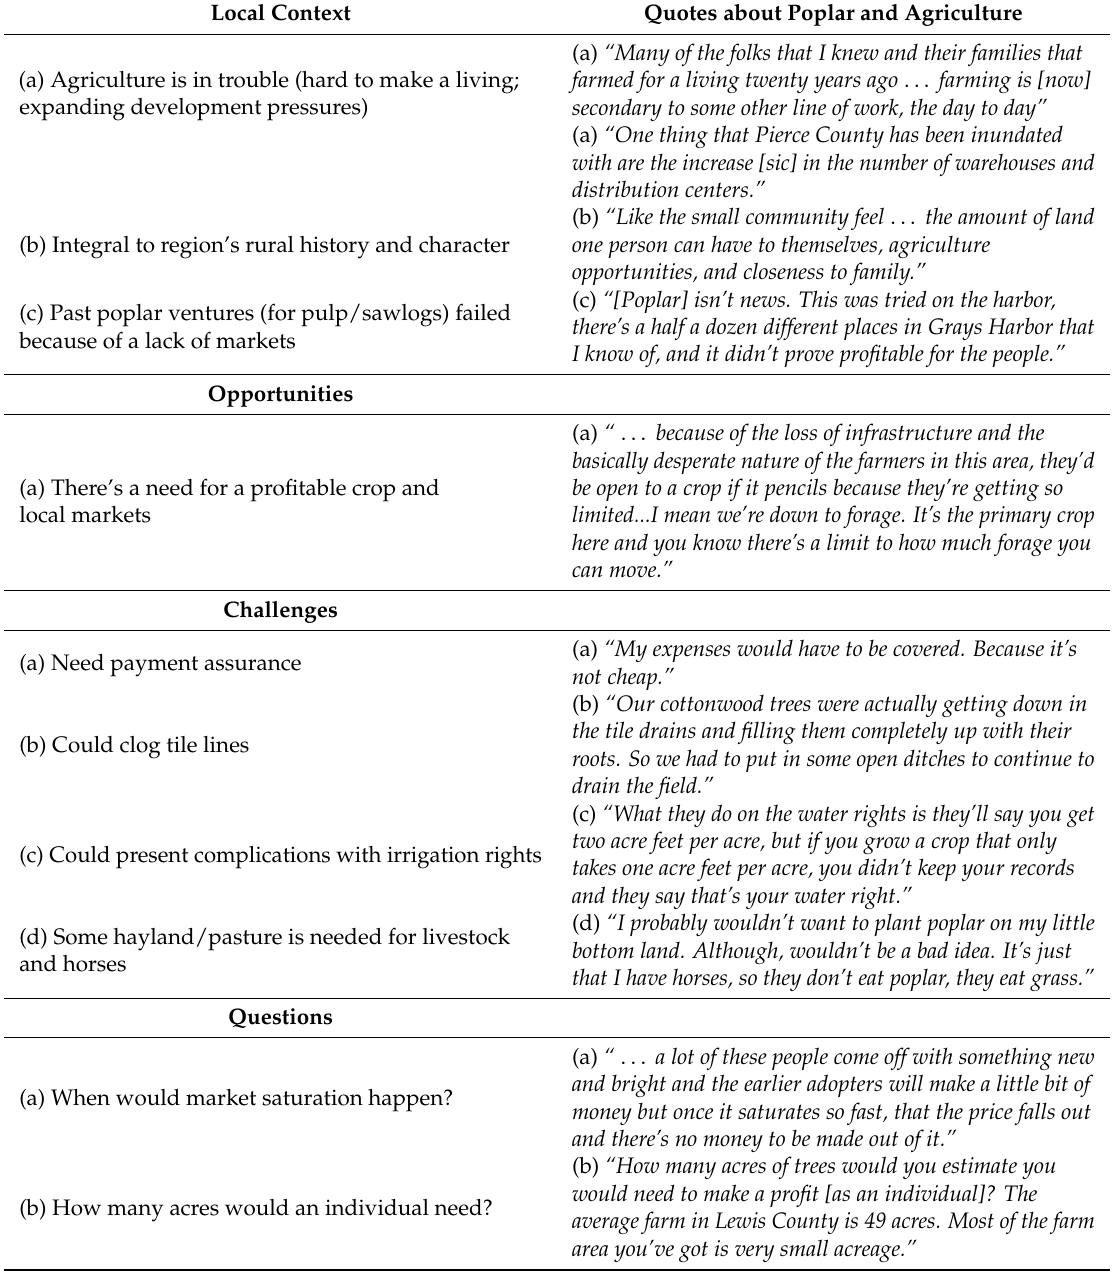
Table 3. Summary and quotes related to the potential for poplar farming to contribute to agriculture in southwestern Washington, from participant stakeholders in agriculture and natural